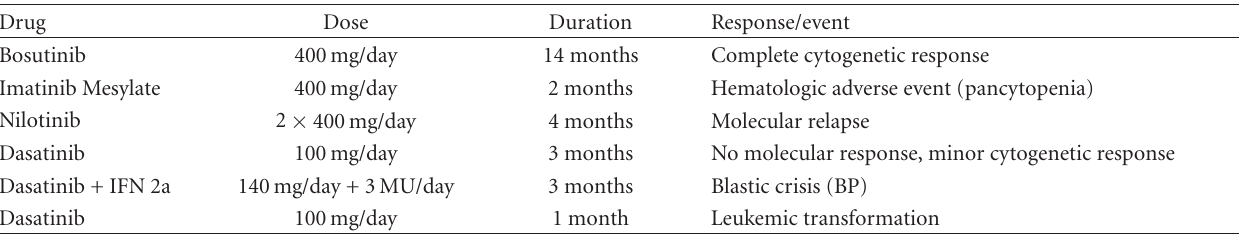
Table 1: A brief summary of the CML treatment schedule including the drug, dosage, duration, and